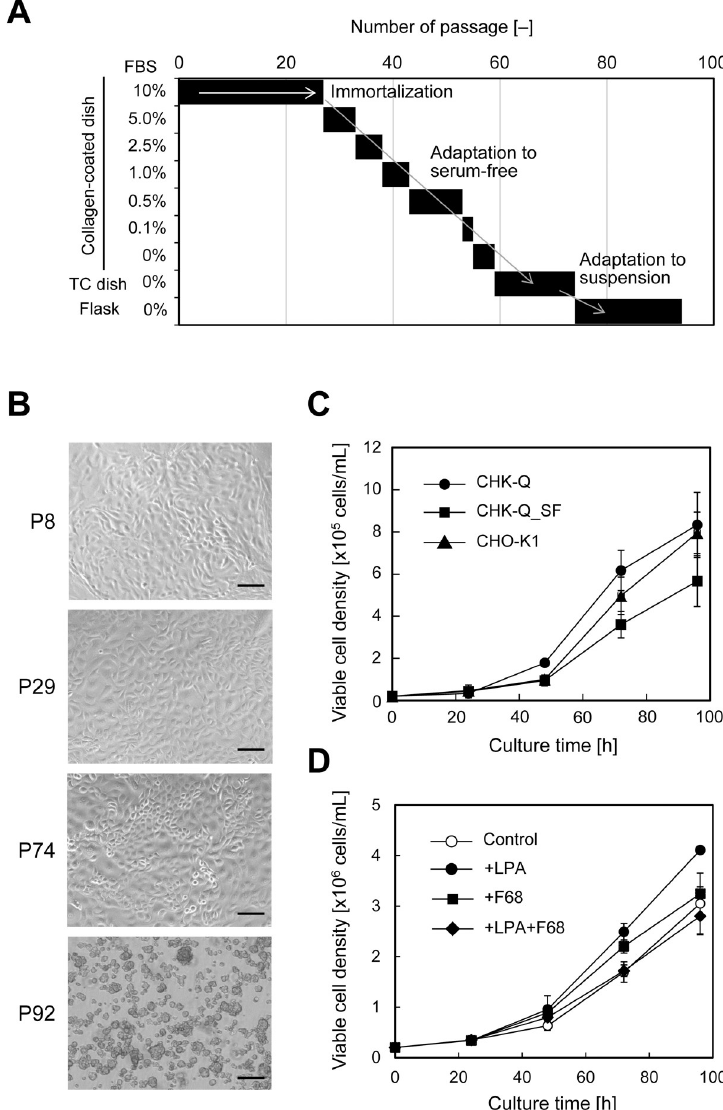
Fig 1. Establishment of CHK-Q cells and serum-free adaptation. (A) Process of the establishment of spontaneously immortalized cells and serum-free adaptation. (B) Cell morphology at each stage: pre-immortalized primary cells, 8th passage (P8); immortalized CHK-Q cells, 29th passage (P29); serum-free adapted CHK-Q_SF cells, 74th passage (P74); and CHK-Q_SS cells adapted to serum-free and suspension conditions, 92th (P92) passage. Scale bars = 100 μ m. (C and D) Cell proliferation curve. CHK-Q, CHK-Q_SF, and CHO-K1 cells were seeded in 24-well plates containing 1 mL medium at a density of 2.5 × 10 4 cells/mL (C). CHK-Q_SS cells were seeded in a 125-mL Erlenmeyer flask containing 30 mL medium with 1 μ M 1-oleoyl lysophosphatidic acid (LPA) and/or 0.1% Pluronic F-68 (F68) at a density of 1 × 10 6 cells/mL (D). Data are expressed as mean ± SD ( n = 3).